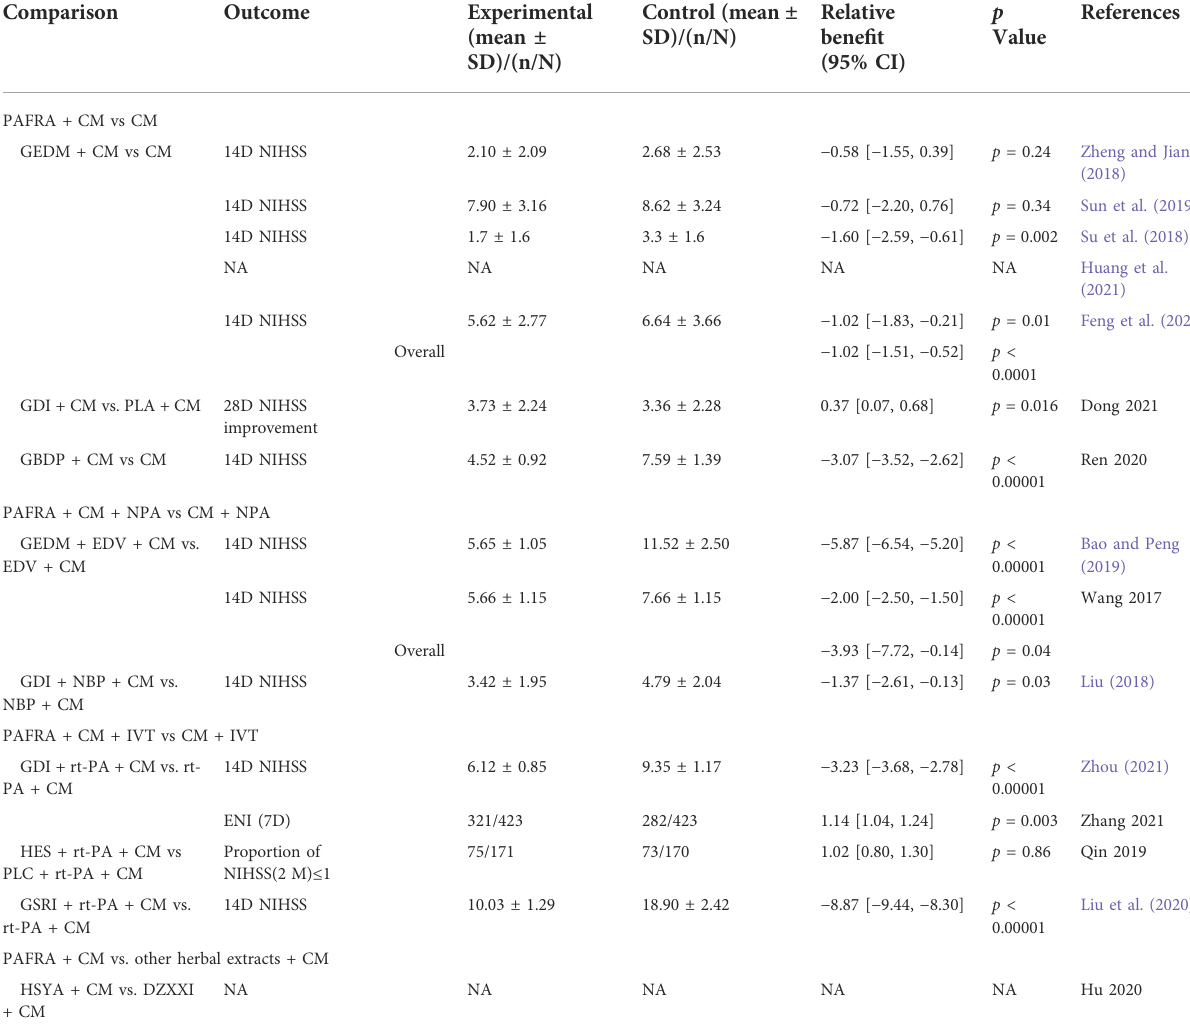
TABLE 3 Effect of platelet-activating factor antagonists on NIHSS in acute ischemic stroke.